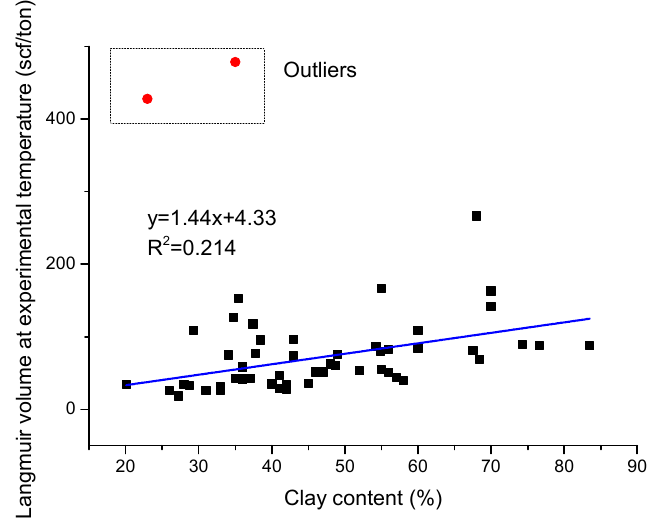
Figure 2. A weak relationship exists between the clay content and Langmuir volume at experimental temperature (30 °C) for the studied shale samples.